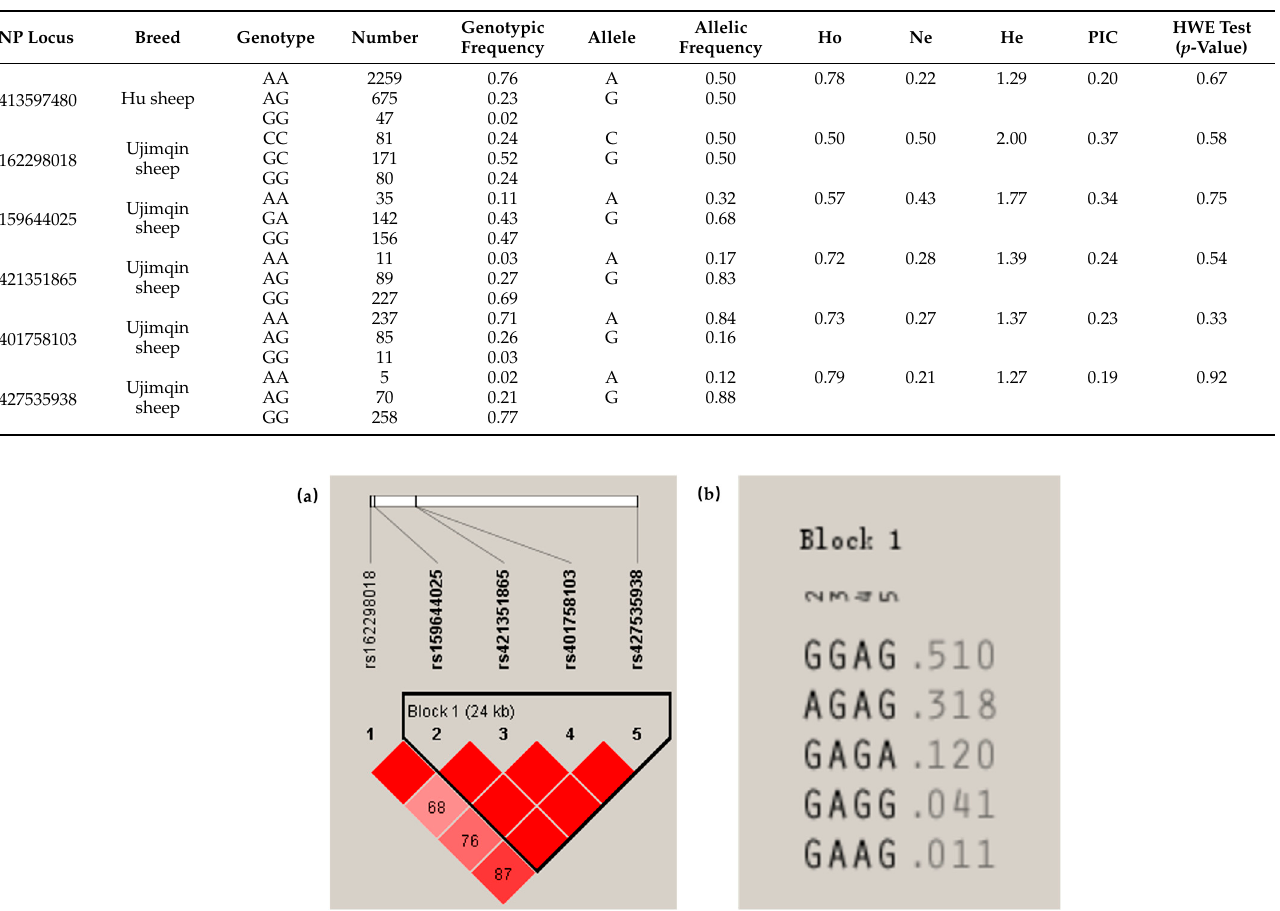
Figure 2 . Analysis of the linkage disequilibrium of five SNPs of the ARNT gene: ( a ) Red squares indicate high levels of interlocking disequilibrium, D’ = 1 indicates complete interlocking disequilibrium, D’ = 0 indicates complete interlocking equilibrium, D values between SNPs in the squares where they cross are shown, no number indicates a D value of 1, and 1–5 correspond to the selected SNPs in Table 1. ( b ) One haploid domain was detected.